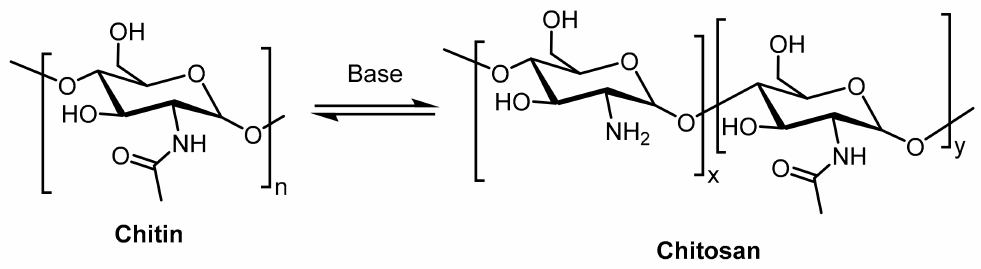
Figure 1. Partial deacetylation of chitin to produce